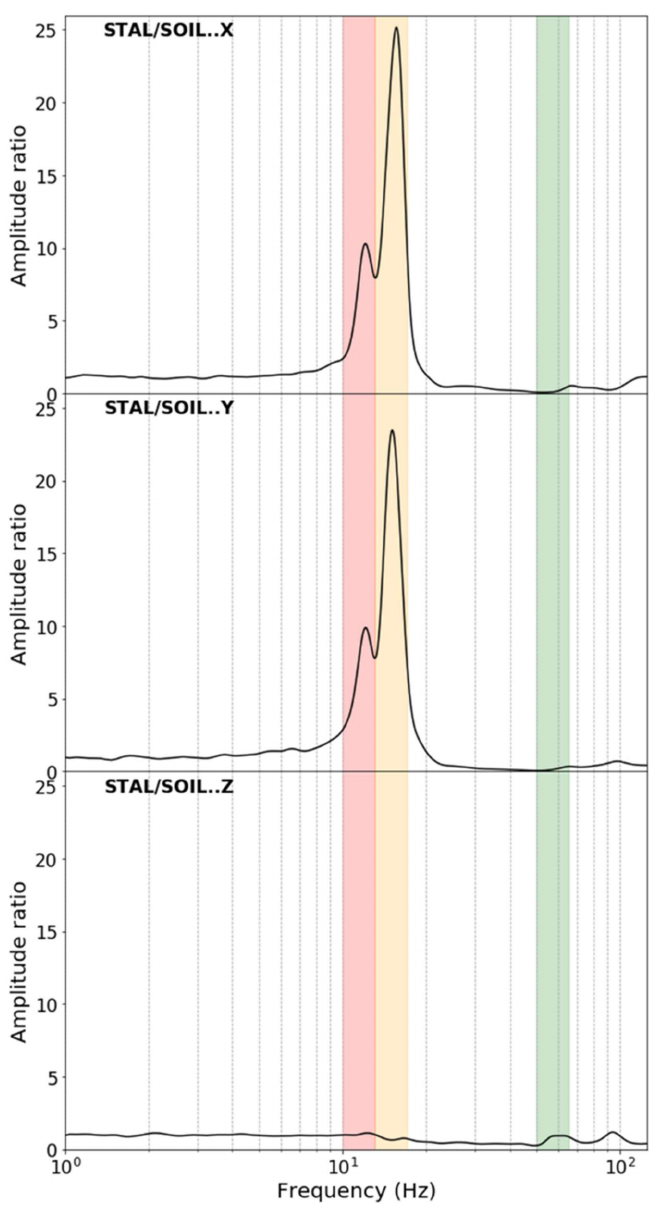
Figure 5. Response of the stalagmite after deconvolution between the stalagmite (STAL) and the signal of the cave ground (SOIL). In red and orange, two split natural frequencies of the first set of peaks, and in green, the position of the second set of peaks of the stalagmite are